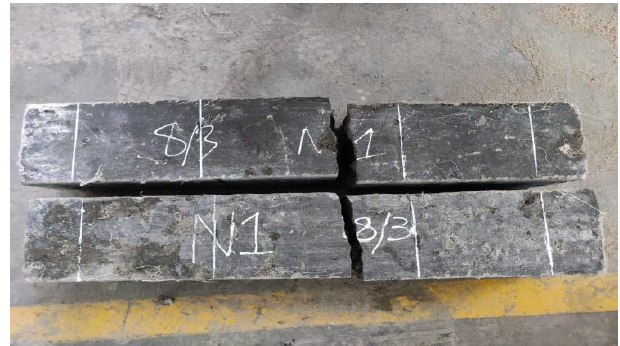
Fig. 7. Flexural strength